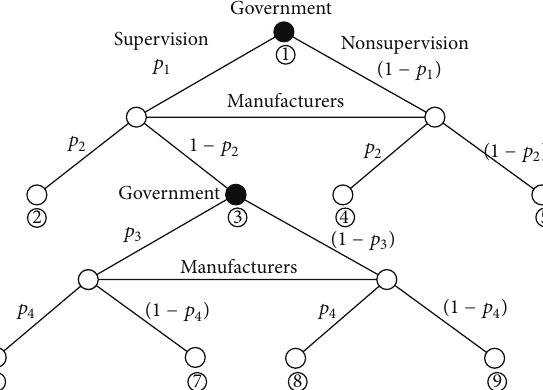
Figure 1: Game tree of government and the